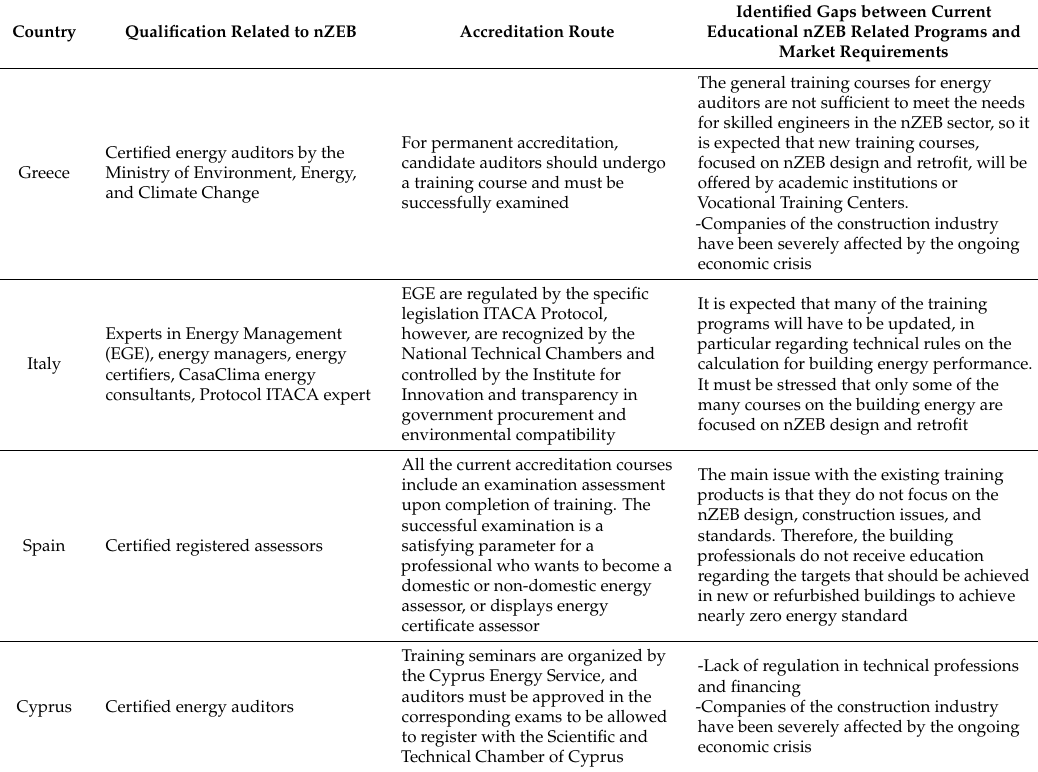
Table 5. Identified gaps between current educational nZEB related programs, qualifications, and training and market